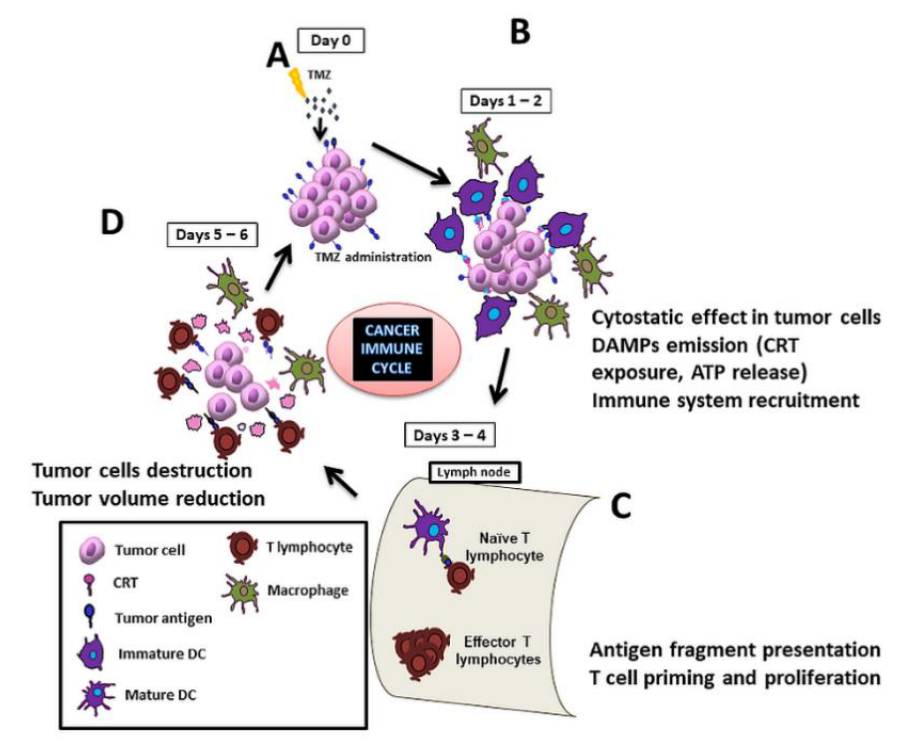
Figure 1. Scheme of the cycle for immune response elicitation against a preclinical glioblastoma (GB) during a full therapy cycle. When treated with temozolomide (TMZ) ( A ), tumor cells release/expose immunogenic signals, such as calreticulin (CRT), which attract dendritic cells (DCs) and macrophages ( B ). DCs migrate to proximal lymph nodes and prime naïve T-cells, which start their proliferation [19]. TMZ (or any antiproliferative agent) should not be administered during this period since it would interfere with lymphocytes’ proliferation and hamper proper immune response ( C ). At days 5–6 of the cycle, effector T cells reach the lesion site and attack tumor cells ( D ).